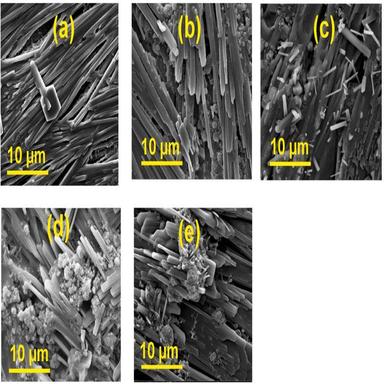
SEM images of the films at various Al2O3 NPs weight percentages: (a) PANI film (without NPs), (b) 5 wt% Al2O3 NPs, (c) 10 wt% Al2O3 NPs, (d) 15 wt% Al2O3 NPs, and (e) 20 wt% Al2O3 NPs.